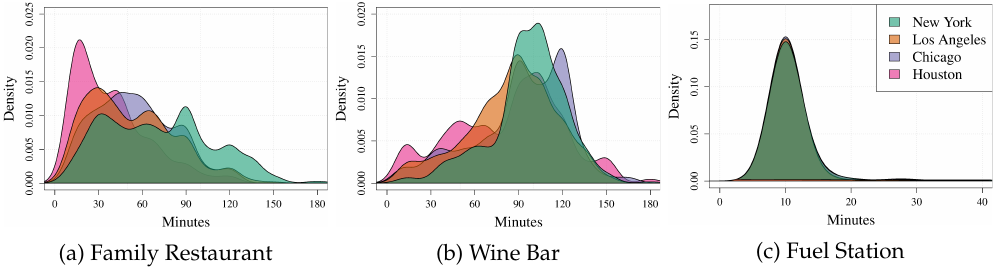
Figure 2: Density plots of visit duration for three place types in January 2020, prior to the COVID-19